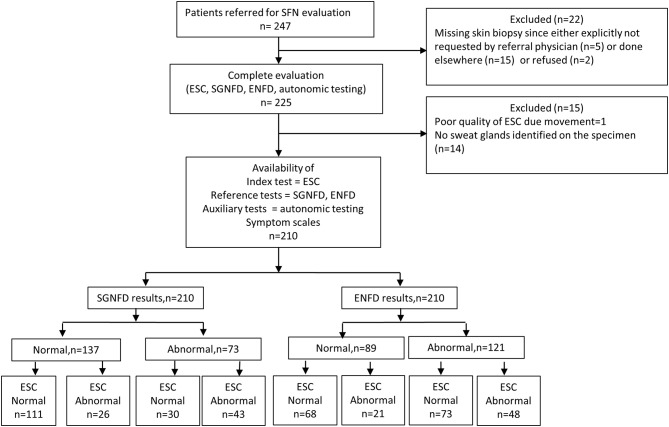
The study flow diagram.